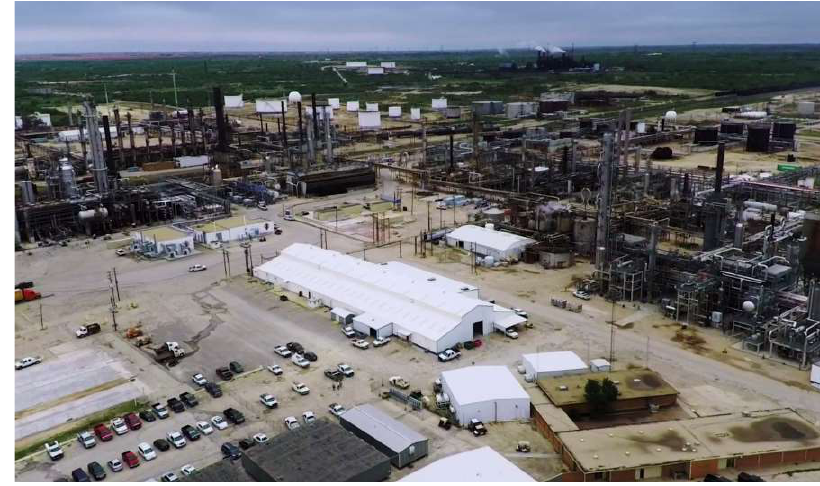
Figure 8. Oil Refinery in Howard County, Texas (image from Google).